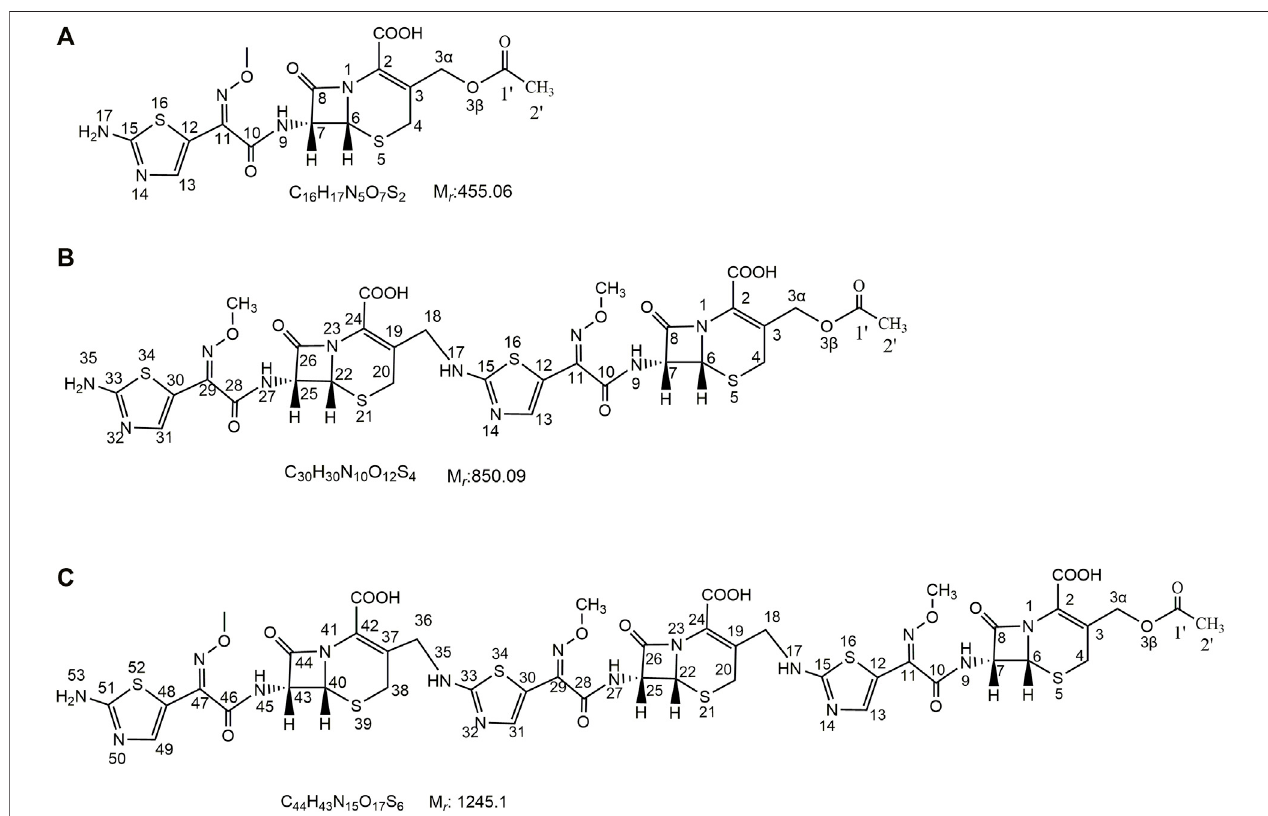
FIGURE 1 | Chemical structures of cefotaxime, cefotaxime dimer and trimer.